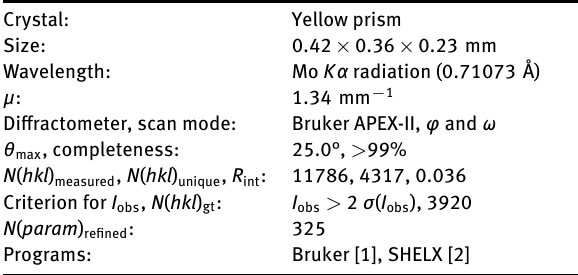
Table 1: Data collection and handling.